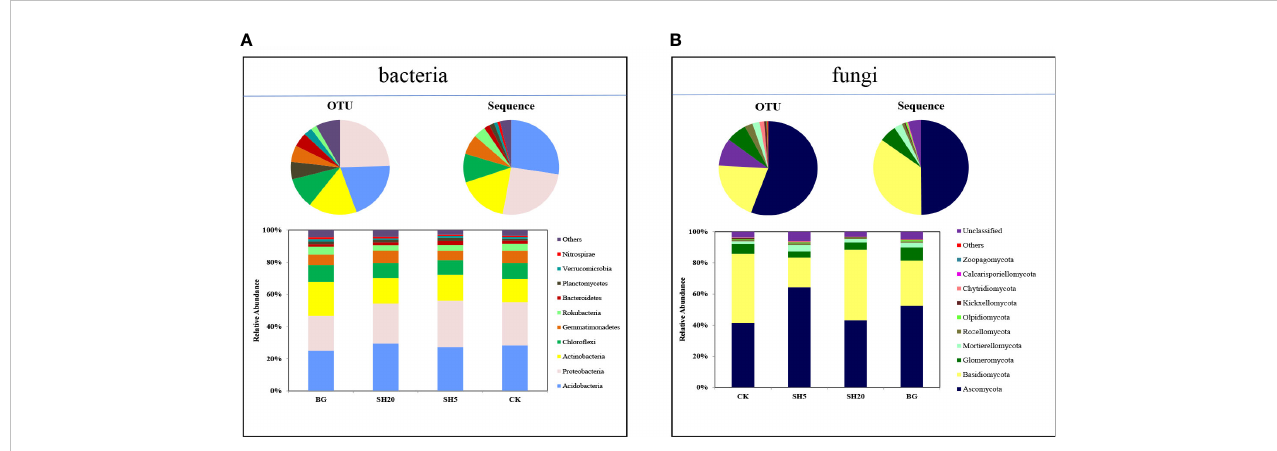
FIGURE 3 Taxonomic compositions (i.e., operational taxonomic unit [OTU], sequence, and relative abundance at the phylum level) of microbial community in soil samples under the CK, BG, SH5, and SH20 treatments: (A) bacteria and (B) fungi.